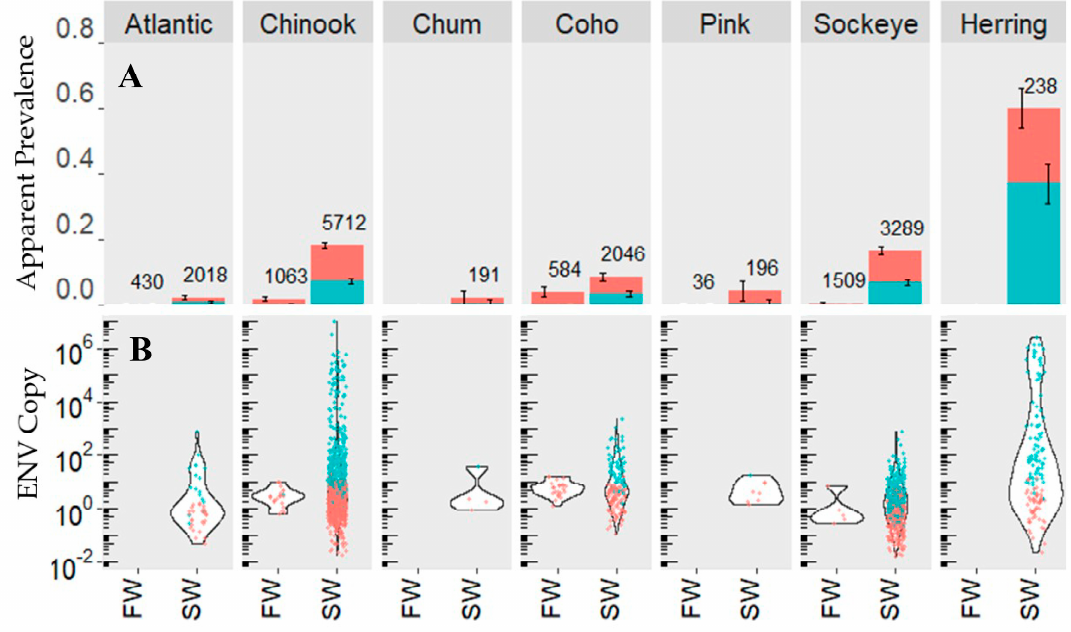
Figure 4. Saline (SW) and freshwater (FW) ENV prevalence ( A ) and load ( B ) among salmon species and herring. Samples with LOD criteria applied are in blue and samples without LOD criteria applied are in coral. Printed values indicate sample sizes and error bars indicate 95% confidence intervals. Only smolts are shown.